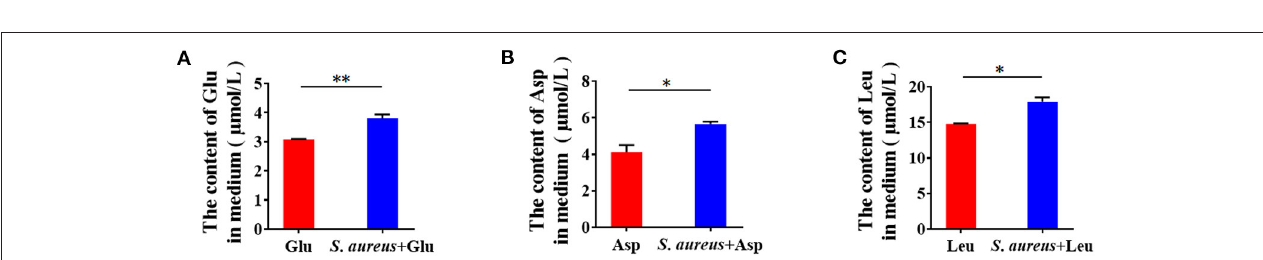
FIGURE 1 | Staphylococcus aureus invasion suppresses milk protein synthesis and secretion in BMECs 8h after infection. (A–C) Levels of intracellular Csn2 ( β -casein), β -lg, and α -la. (D–F) Levels of Csn2 ( β -casein), β -lg and α -la in cell culture medium. ** p < 0.01. n = 3 independent experiments.